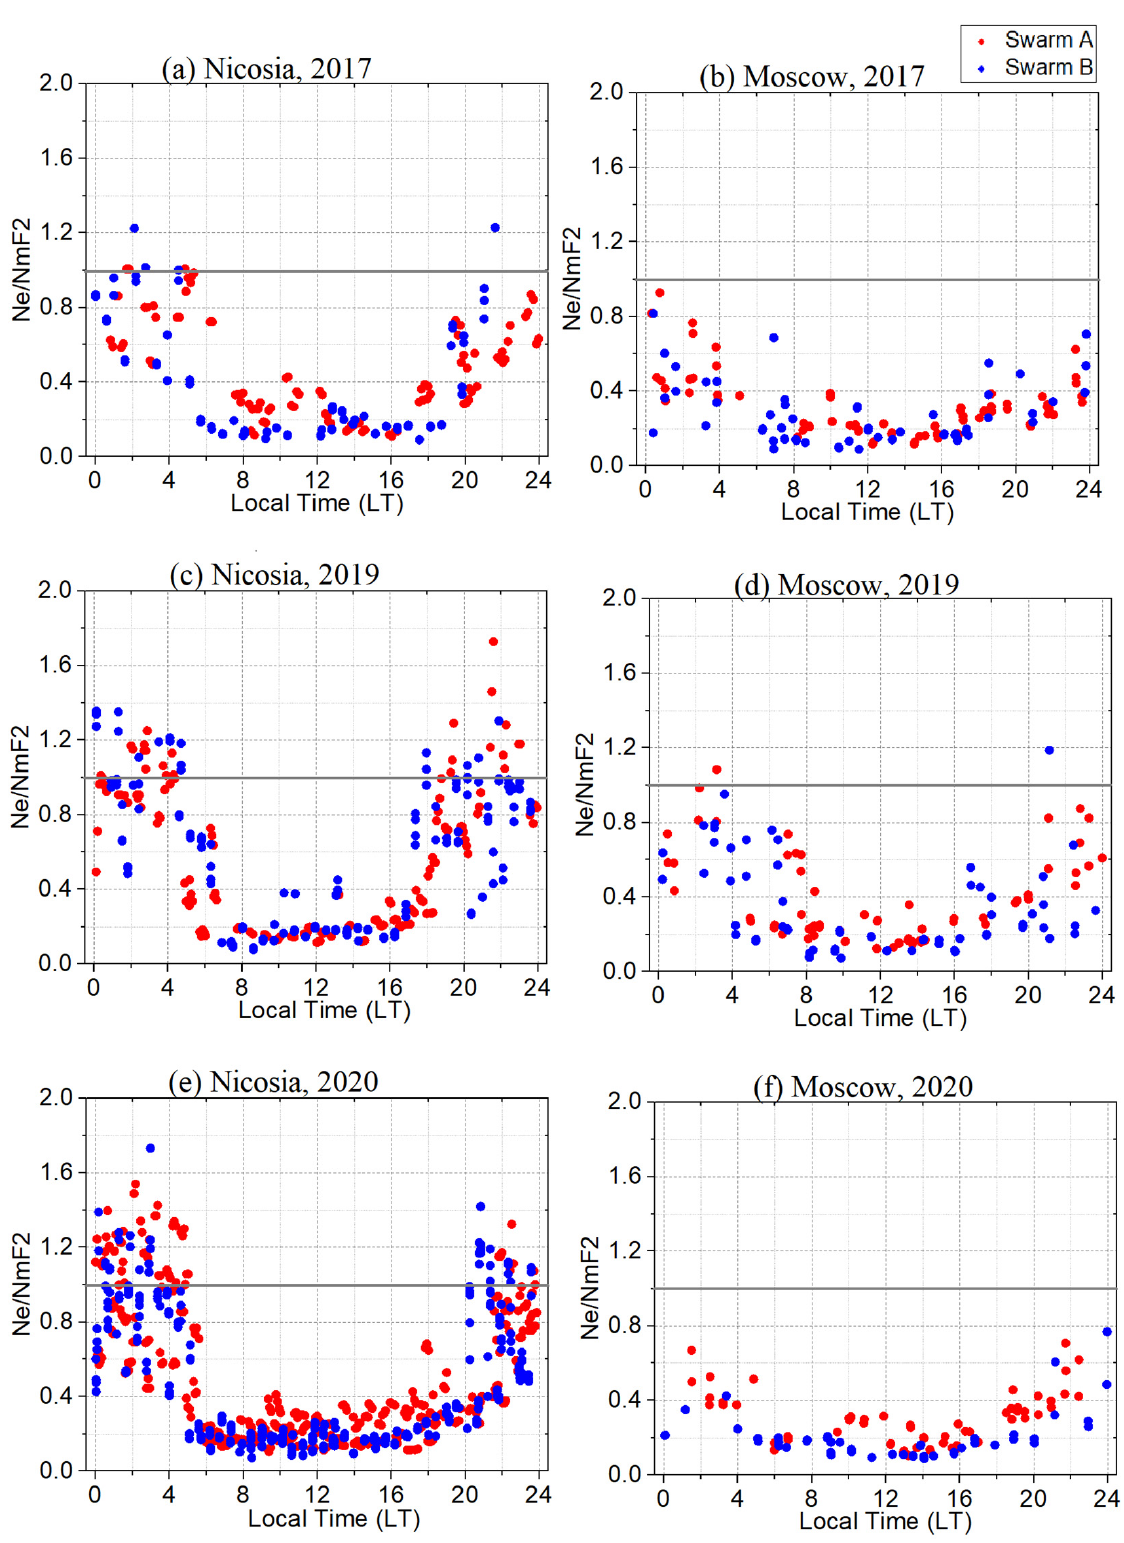
Figure 3. ( a – f ). Comparison of Ne/NmF2 from Swarm A and B over Moscow and Nicosia for moderate-to-low solar activity during 2017, 2019 and 2020. Table 1. Percentage of observations for Ne/NmF2 ≥ 1 over Nicosia and Moscow.